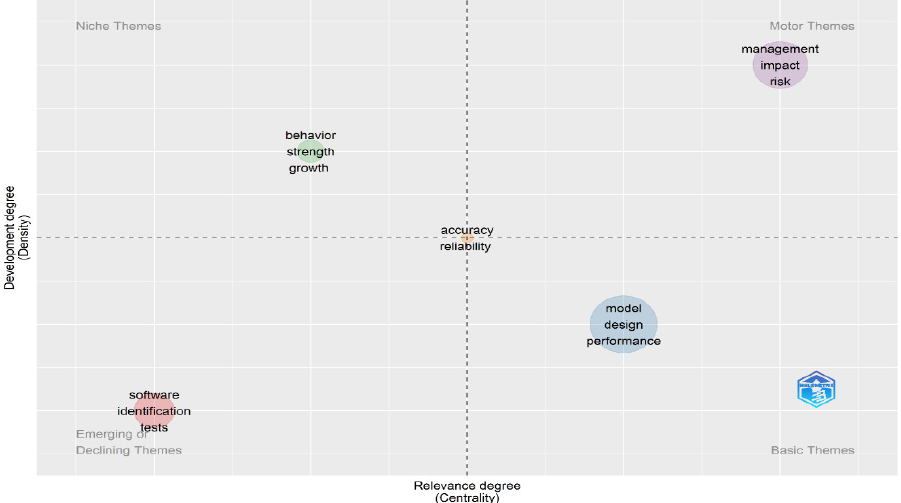
Figure 16. Thematic Map for the years (2016–2018).